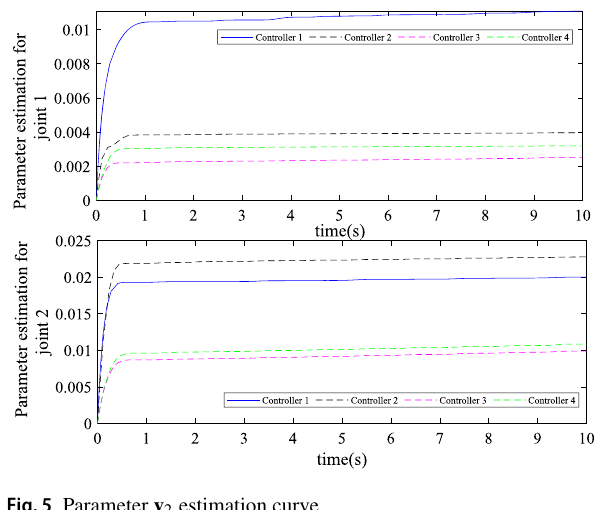
Fig. 4 Parameter v 1 estimation curve